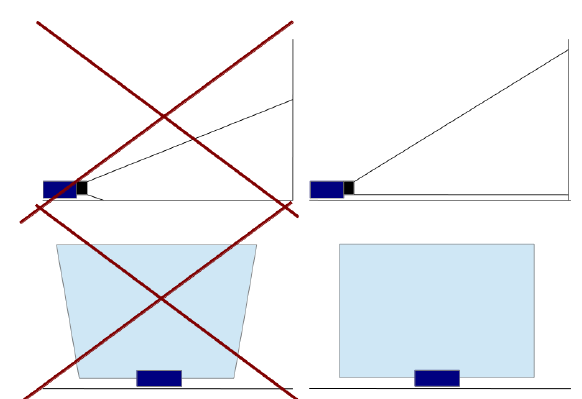
Figure 4: A projector beams “up” (top right) rather than horizon- tal (top left). Nevertheless the projected image is a rectangle (bot- tom right) rather than a trapezoid (bottom left). This is achieved by shifting the lens upwards w.r.t. the LCD array, giving a large value for vertical principal point offset.